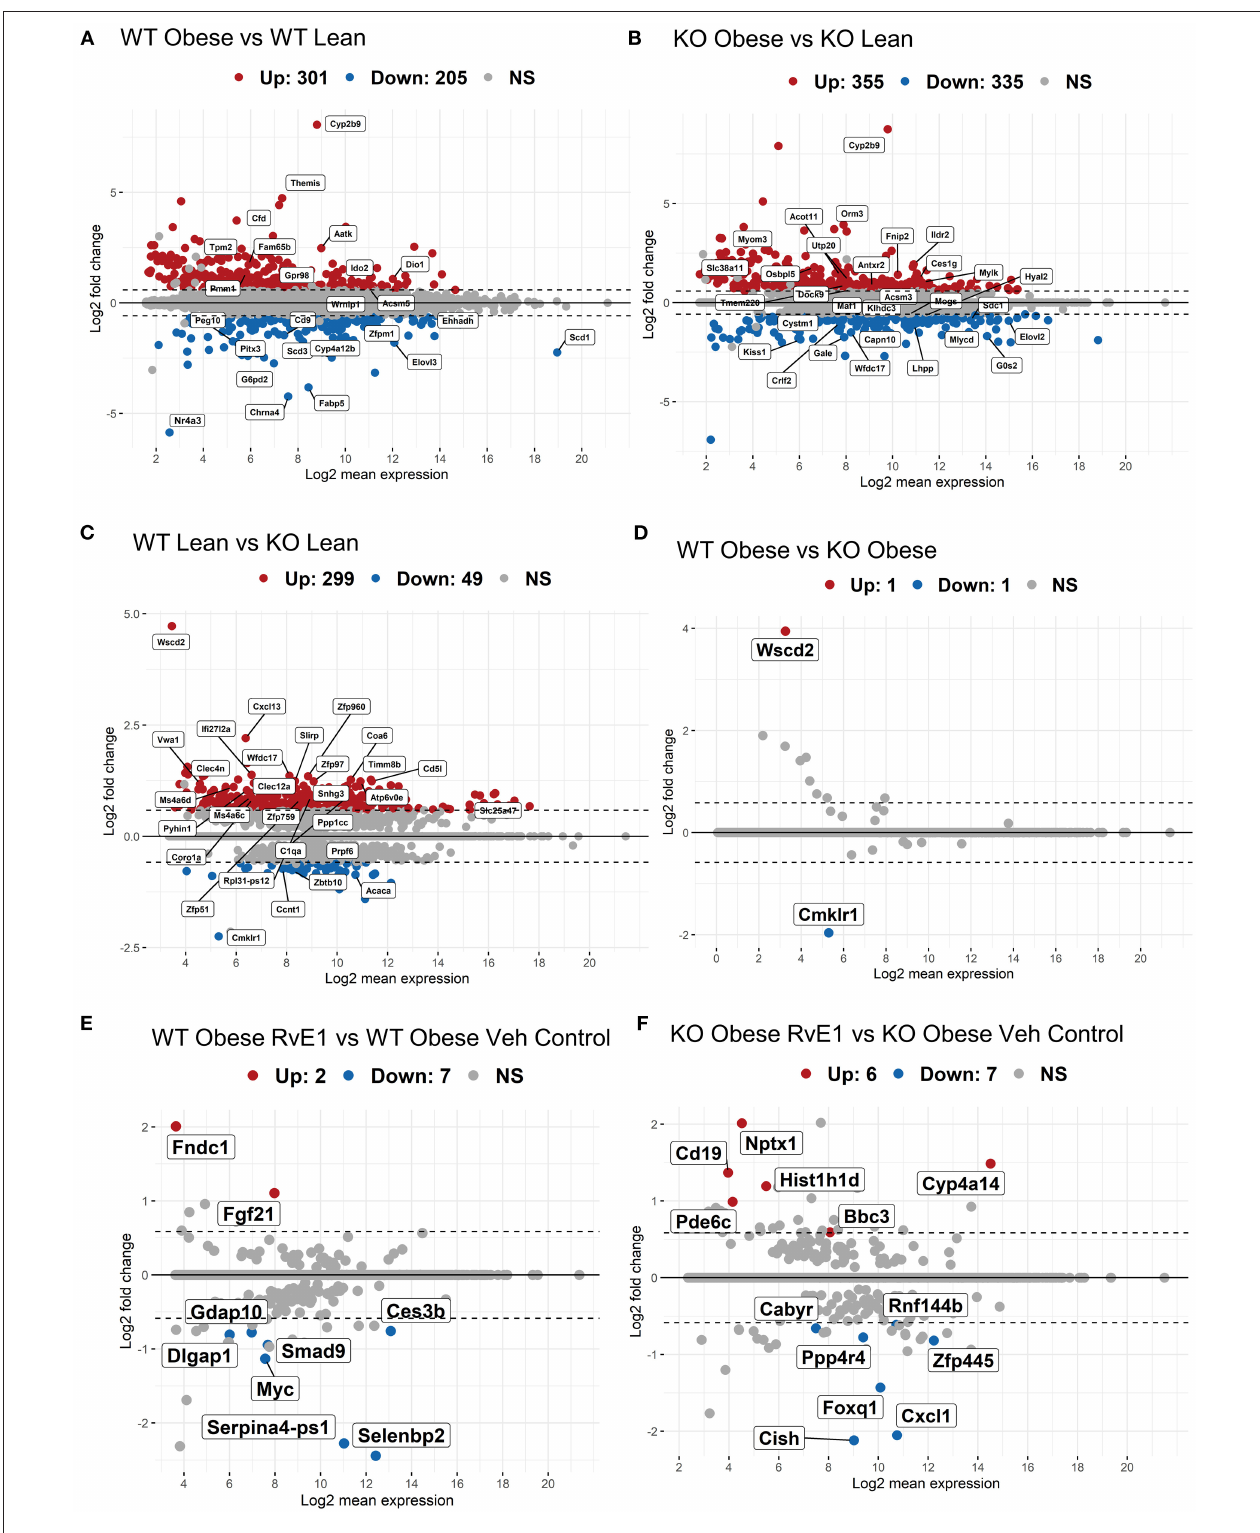
FIGURE 1 | Obese WT and ChemR23 KOs in the absence and presence of RvE1 display differential expression of liver metabolic and immunological transcripts. MA plots showing genes with a BH-adjusted p -value below 0.1 and Log2 fold change (FC) above 1.5 plotted by Log2FC in the y-axis and Log2 mean expression in